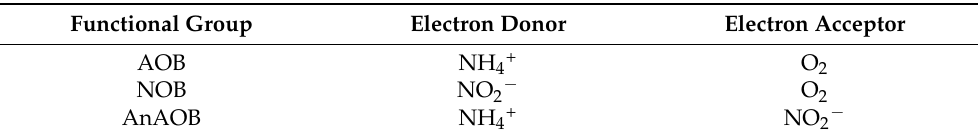
Table 1. Substrate and electron donors specified for the main microbial groups involved in nitro- gen metabolism.